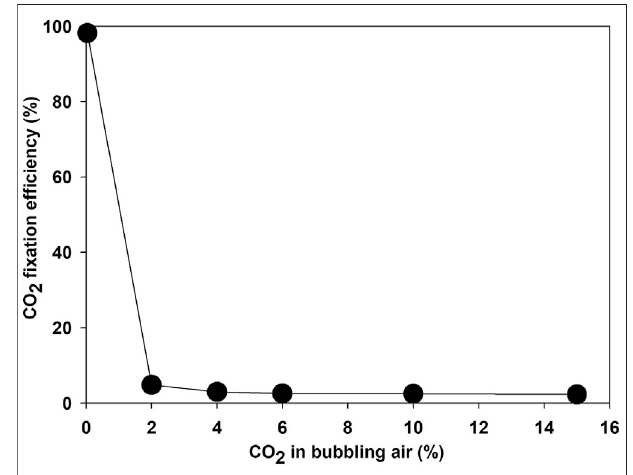
FIGURE 4 | CO 2 fi xation rate of Parachlorella kessleri HY-6 at different light intensities and CO 2 concentrations.